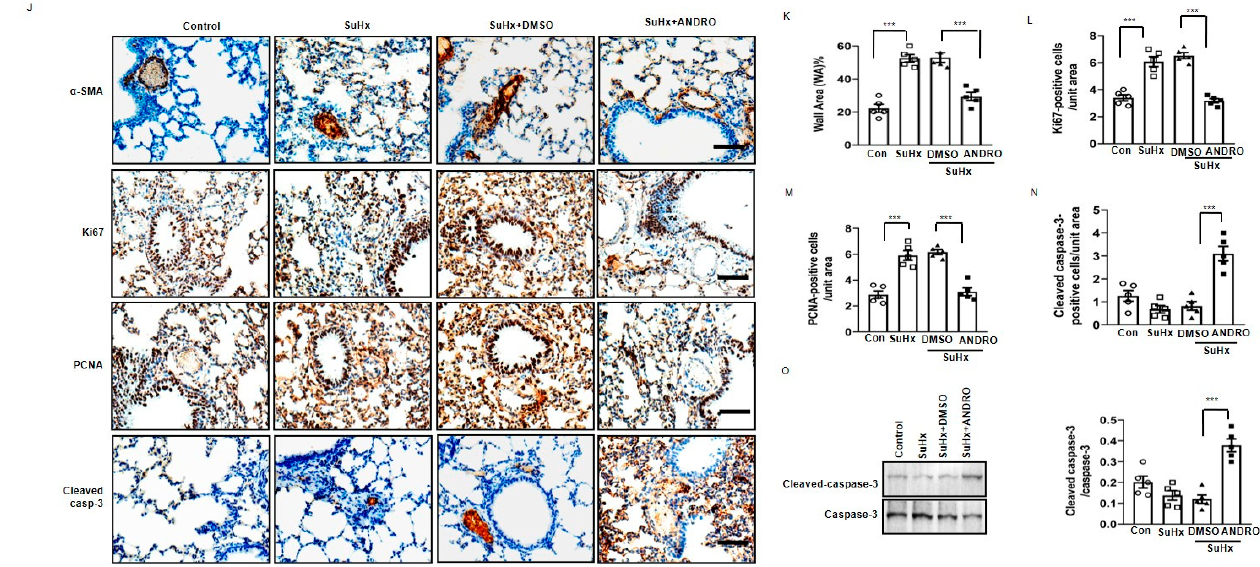
Figure 2. Therapeutic effects of ANDRO in a SU5416-hypoxia (SuHx)-induced mouse PH model. ( A ) Protocol of animal experiments. For SuHx-induced PH group, mice were subjected to three weeks hypoxia + Su5416 injection. ANDRO (1 mg/kg/day, i.p.) or DMSO (vehicle) were given for two weeks after three weeks of hypoxia + Su5416 injection. Control mice were subjected to five weeks normoxia only. n = 8. ( B ) Representative tracings showing the effect of ANDRO on PA systolic pressure in SuHx-induced PH mouse model. n = 8. ( C ) ANDRO treatment significantly attenuated the elevated RVSP in SuHx-induced PH mice. n = 8. ( D ) ANDRO reversed RV hypertrophy in SuHx-induced PH mice assessed invasively by the right ventricular hypertrophy index. ( E , F ) ANDRO failed to affect systemic pressure or cardiac output. n = 8. ( G ) Representative H&E staining (upper panel) and α -SMA immunofluorescence staining (lower panel) images showing the vascular remodeling in various groups. ( H ) Quantitative analyses showing that ANDRO significantly reduced the ratio of neointima/media. ( I ) Quantification of non-, partially and fully muscularized arteries as a percentage of total alveolar wall and duct arteries ( n = 5, one-way ANOVA for fully muscularized vessels). ( J – O ) Representative immunohistochemical photomicrographs of serial lung sections and group data showing that ANDRO significantly reduced the increased expression of α -SMA (WA%, K ), ratio of Ki67 positive cells ( L ) and ratio of PCNA positive cells ( M ) in SuHx-induced PH mice. ANDRO also significantly increased apoptosis, as reflected by cleaved-caspase-3 ( N ). This is further supported by Western blotting analysis ( O ). n = 5. Results are expressed in percent (%) calculated as follows: (number of positive cells divided by the total number of hematoxylin-stained nuclei) × 100, from six arteries per group. Scale bars, 100 µ m. Data represent mean ± SEM. ** p < 0.01; *** p < 0.001; n.s.: no significant